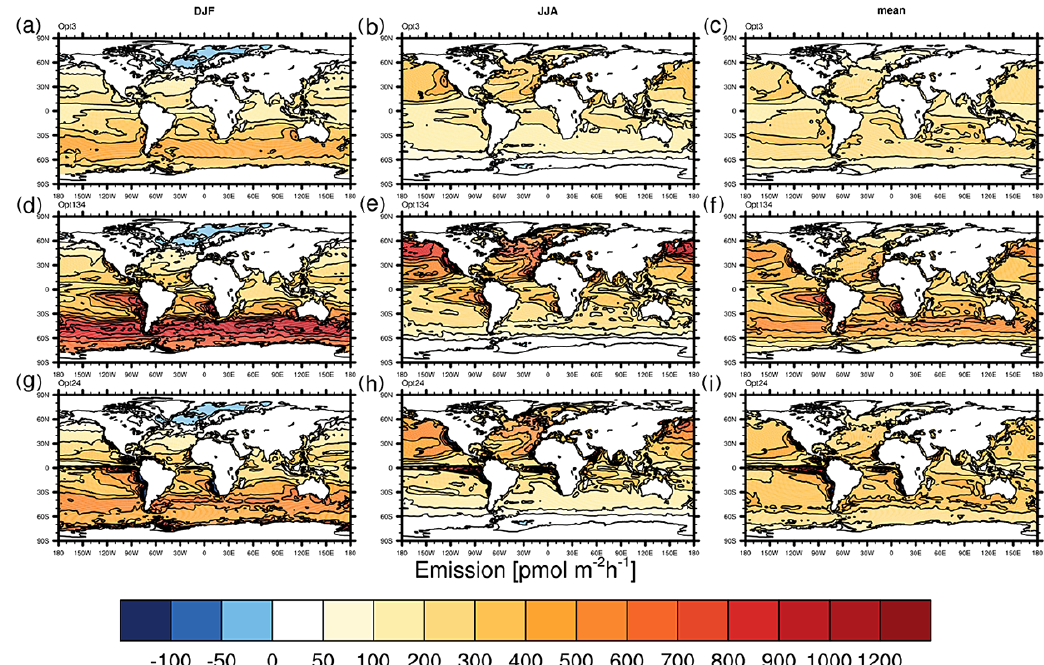
Figure 12. Emissions into the atmosphere (pmolm − 2 h − 1 ) in Opt4 (a–c) , Opt134 (d–f) and Opt24 (g–i) in DJF (a, e, i) and in JJA (c, g, k) ; annual mean (c, f, i)